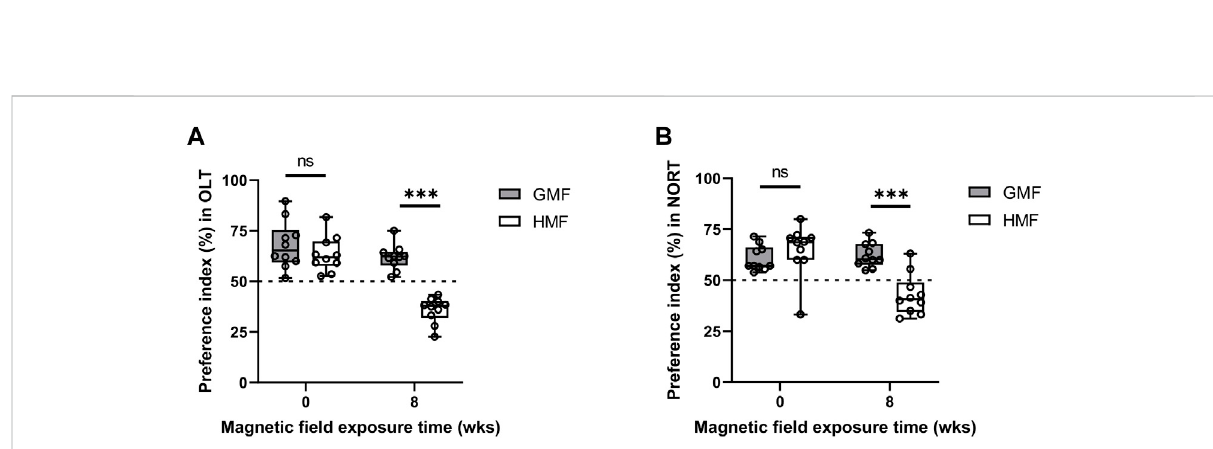
FIGURE 8 Exposure to hypomagnetic fi eld (HMF) impaired hippocampal-dependent cognition. (A) Comparison of preference index in novel location recognition test between the GMF-exposed group and HMF-exposed group ( P 8w < 0.0001). (B) Comparison of preference index in novel object recognition test between the GMF-exposed group and HMF-exposed group ( P 8w < 0.0001). Boxplots show the median value (horizontal line), box limits indicate the 25th and 75th percentiles (box size covers the central 50% of the data), whiskers show extreme values of data distribution (maximal and minimal values within total range). There were 10 mice in each group at each time point. ns means no signi fi cance. *** p < 0.001. GMF means geomagnetic fi eld; wks means